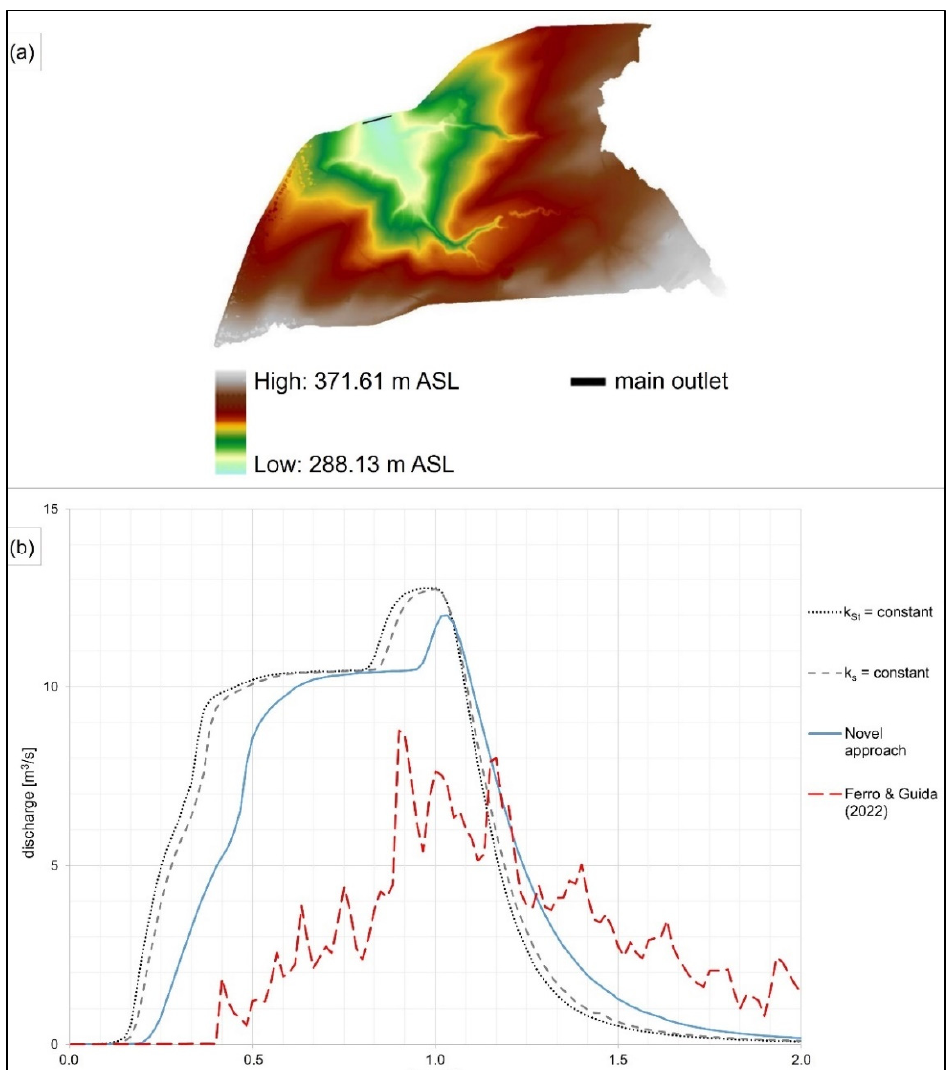
Figure 8. Model area and 2D results: ( a ) DEM of the model and location of the main outlet, ( b ) hydrograph for different scenarios at the main outlet.